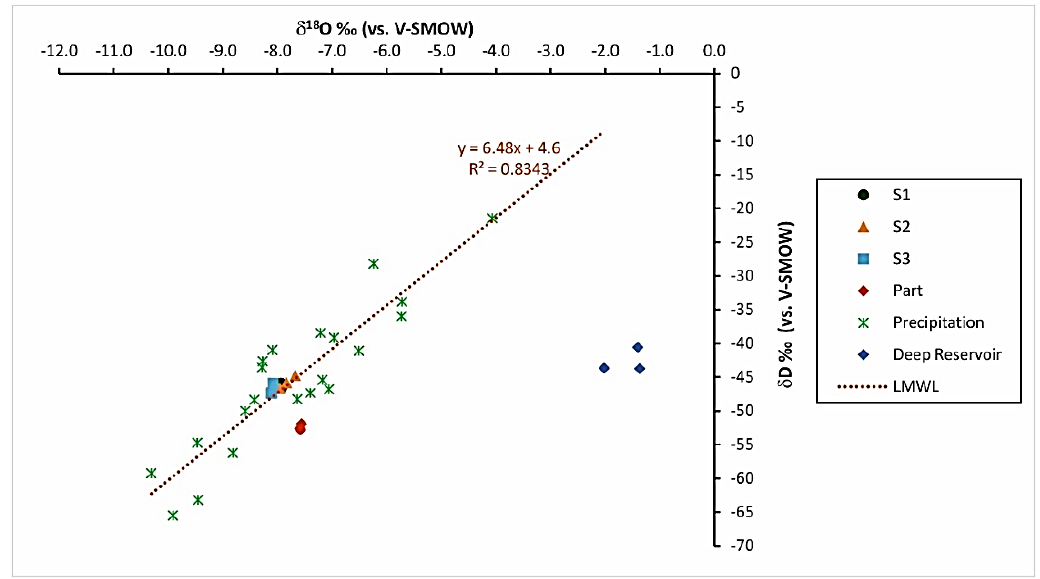
Figure 5. δ 18 O versus 𝛿 2 H relationship in water samples collected from rainwater samplers, at springs (S1; S2; S3), at the artesian well (P art ), and in the deep reservoir. LMWL is the local meteoric water line